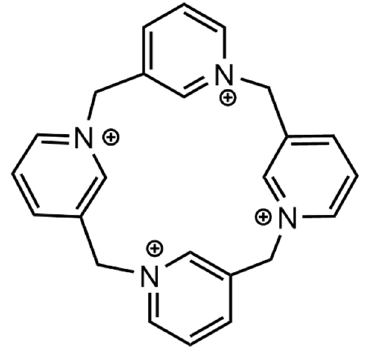
Figure 14. Structure of the receptor calixpyridinium, C4Pyr.